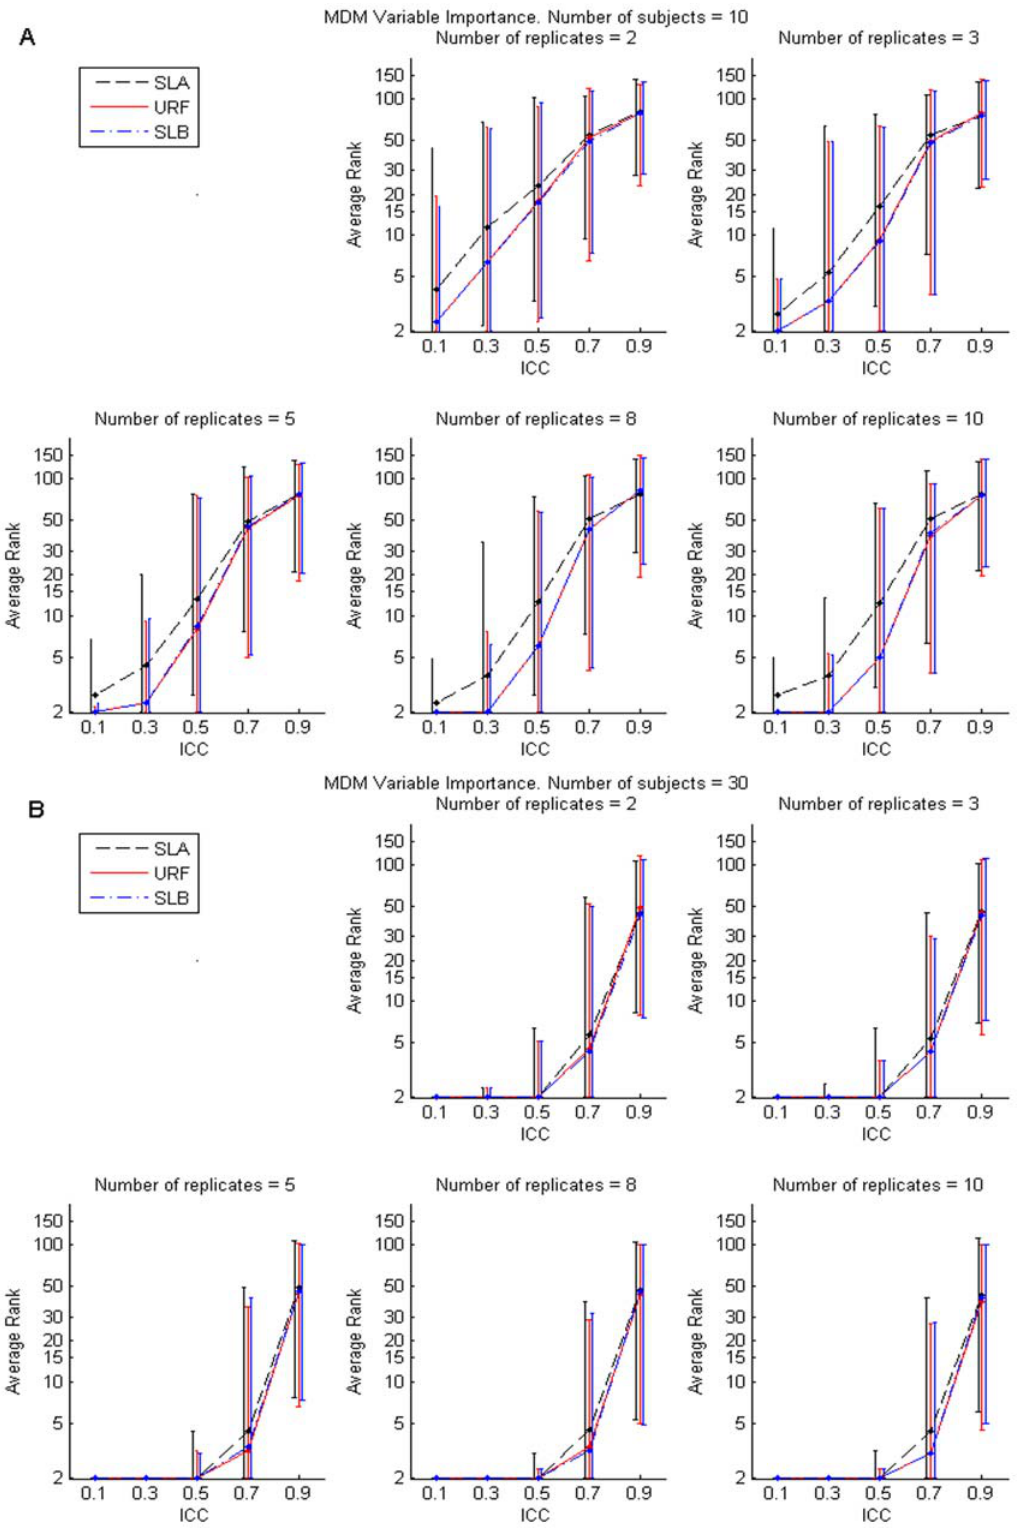
Figure 1. Mean Decrease in Margin (MDM) variable importance. Median and the 5 th and 95 th percentiles of the logarithm of the average ranks of the MDM variable importance scores for the three discriminating variables for 200 simulations (see text) with forests grown on ten subjects (panel A) and 30 subjects (panel B). The median is depicted by a dot, and vertical bars represent the 5 th and 95 th percentiles. Vertical bars are separated artificially along the x-axis to improve visual representation. Results for SLB and URF forests grown on subject-level bootstrapped data correspond to dot-dashed blue and solid red lines, respectively. The dashed black lines correspond to SLA.